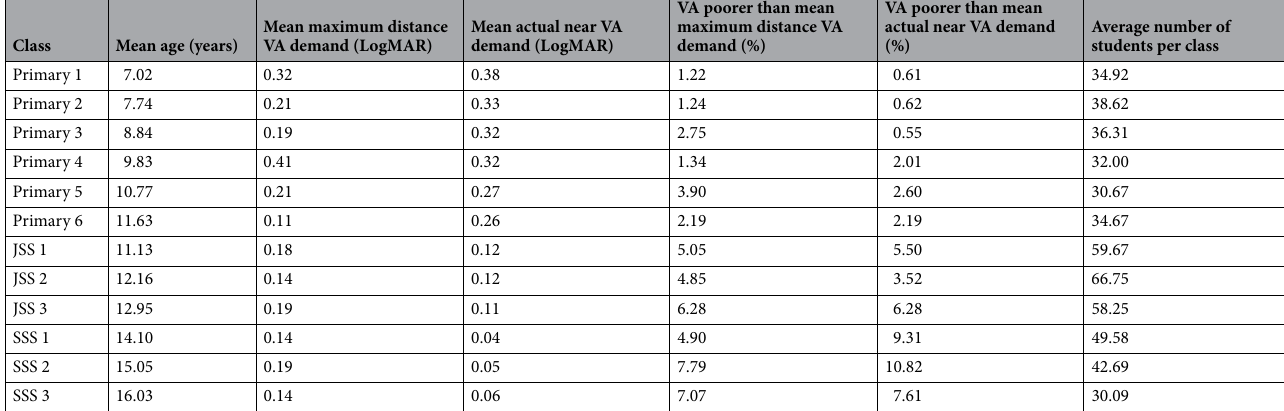
Table 5. The percentage number of students in each class with VA poorer than the mean VA demand at distance and near. JSS Junior Secondary School, SSS Senior Secondary